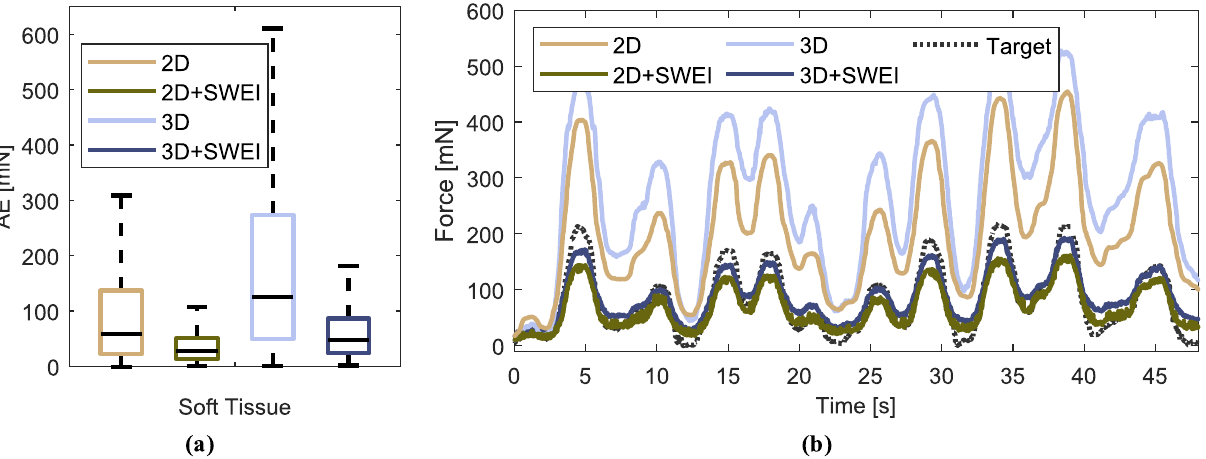
Figure 7. Ex-vivo Soft Tissue: (a) Absolute errors across all soft tissue samples plotted for each model. Accounting for sample elasticity results in superior generalization from gelatin to soft tissue. (b) Example force estimates for the palpation of a tissue sample for all trained models.